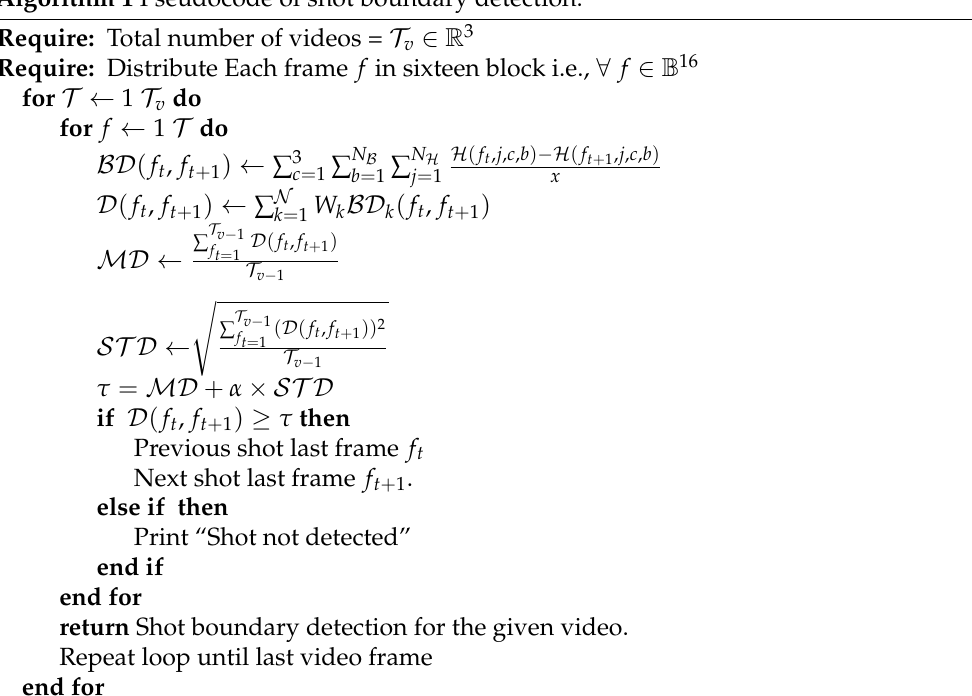
Algorithm 1 Pseudocode of shot boundary